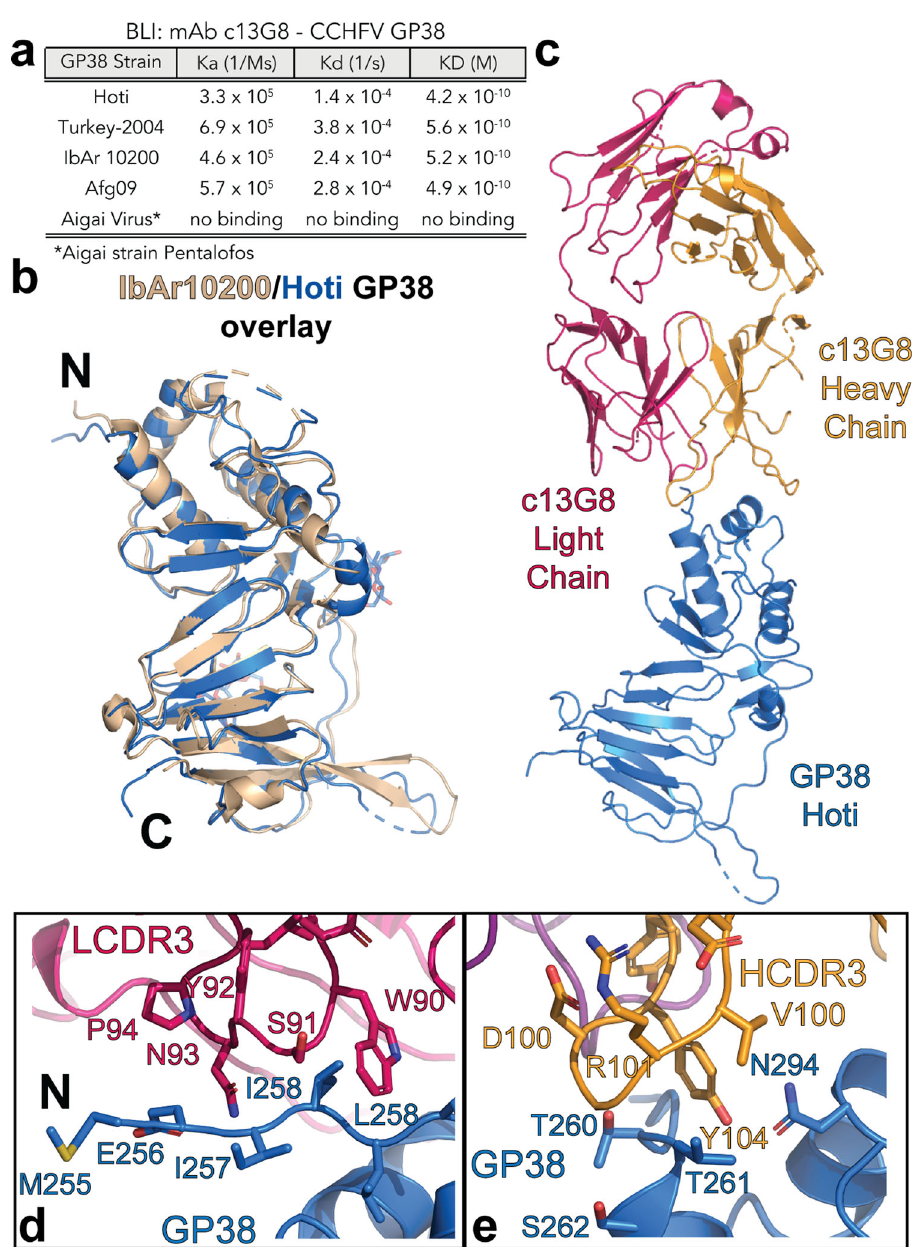
Fig. 1 | c13G8 interactions with nairovirus GP38. a BLI binding kinetics of c13G8 withnairovirusGP38s. b OverlayofCCHFVIbAr10200GP38(PDBID6VKF)(wheat) with our solved CCHFV Hoti GP38 Structure (PDBID 8DC5) (blue) c , c13G8 Fab